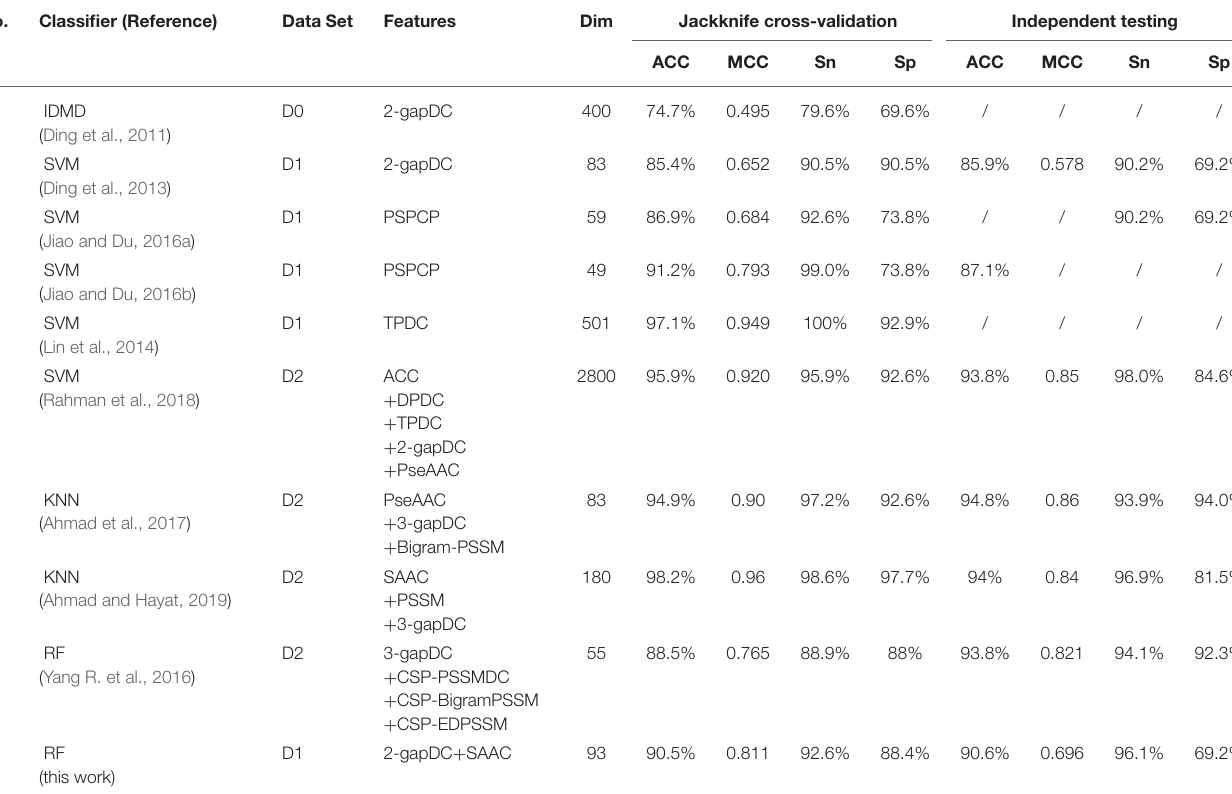
TABLE 3 | Jackknife cross-validation and independent testing scores list for reported sub-Golgi protein classifiers.